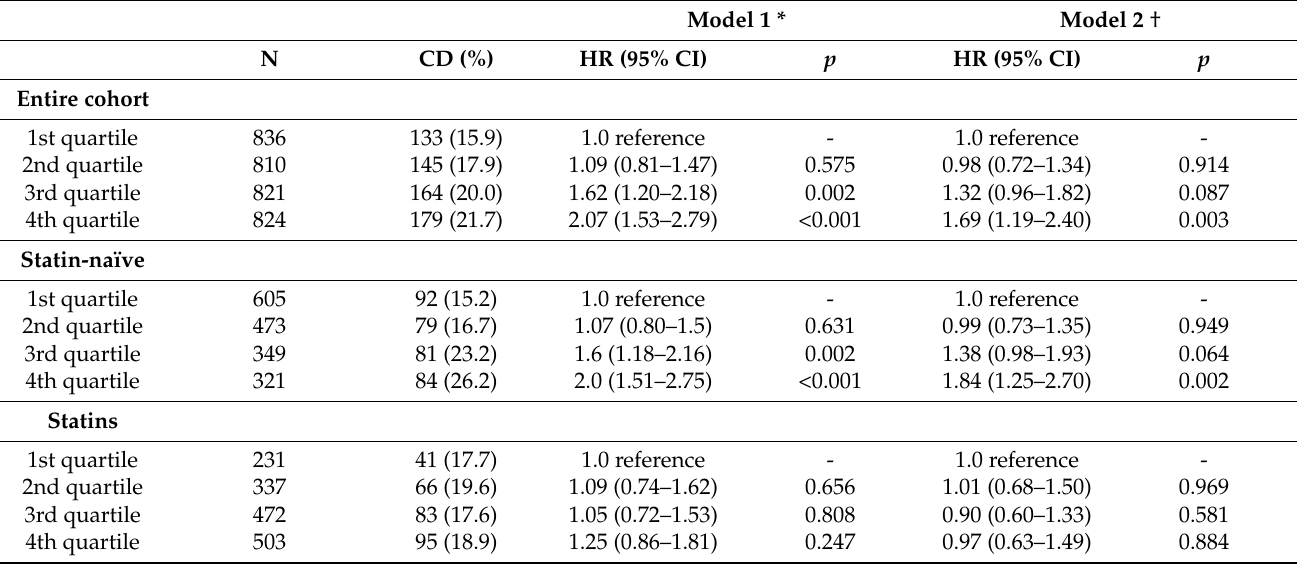
Table 2. Cardiovascular mortality according to LDLapoB/LDLC meas quartiles in the LURIC cohort. Model 1 *